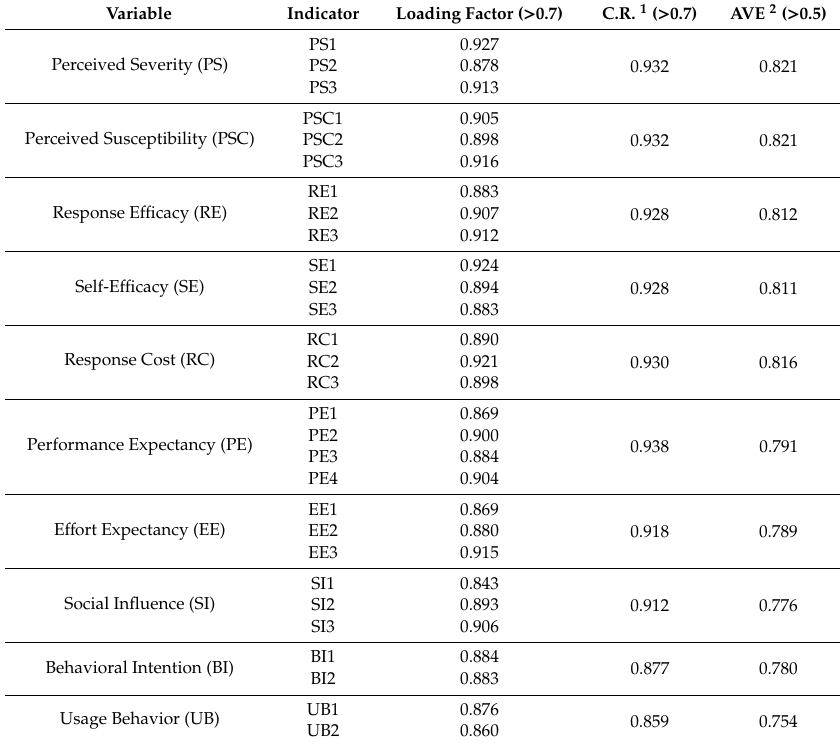
Figure 2. The path diagram and the measurement model. The number inside the construct shows composite reliability; and the number between construct and indicator is the loading factor of each indicator. The constructs are Performance Expectancy (PE), Effort Expectancy (EE), Self-Efficacy (SE), Social Influence (SI), Perceived Severity (PS), Perceived Susceptibility (PSC), Response Cost (RC), Response E ffi cacy (RE), Behavioral Intention (BI), and Usage Behavior (UB). The label inside the indicator symbol shows the indicator code for each corresponding construct. Table 3. Loading factor, internal consistency, and convergent validity.